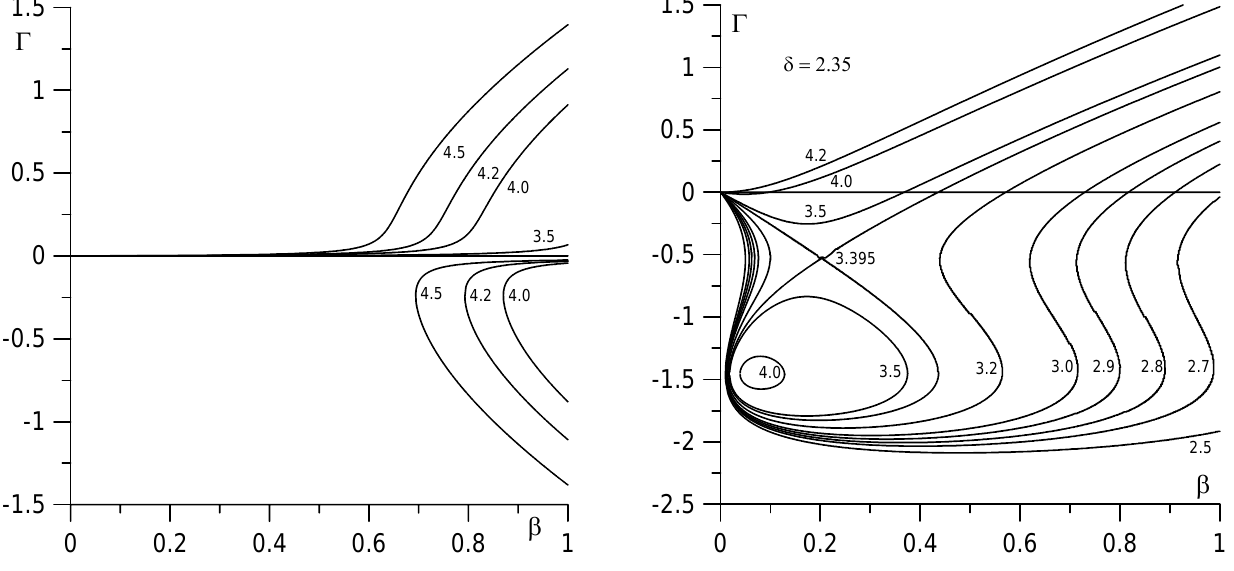
Figure 5c. The same for (slightly below the 35.2 =δ